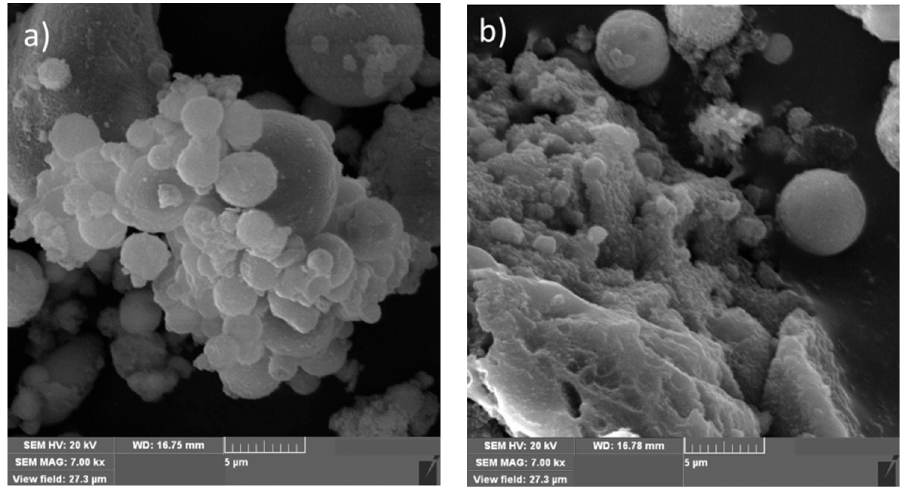
Figure 1. Scanning electron microscope (SEM) images of coal fly ash; ( a ) raw FA and ( b ) H 2 O 2 -treated FA. Figure1. Scanningelectronmicroscope(SEM)imagesofcoalflyash; ( a )rawFAand( b )H